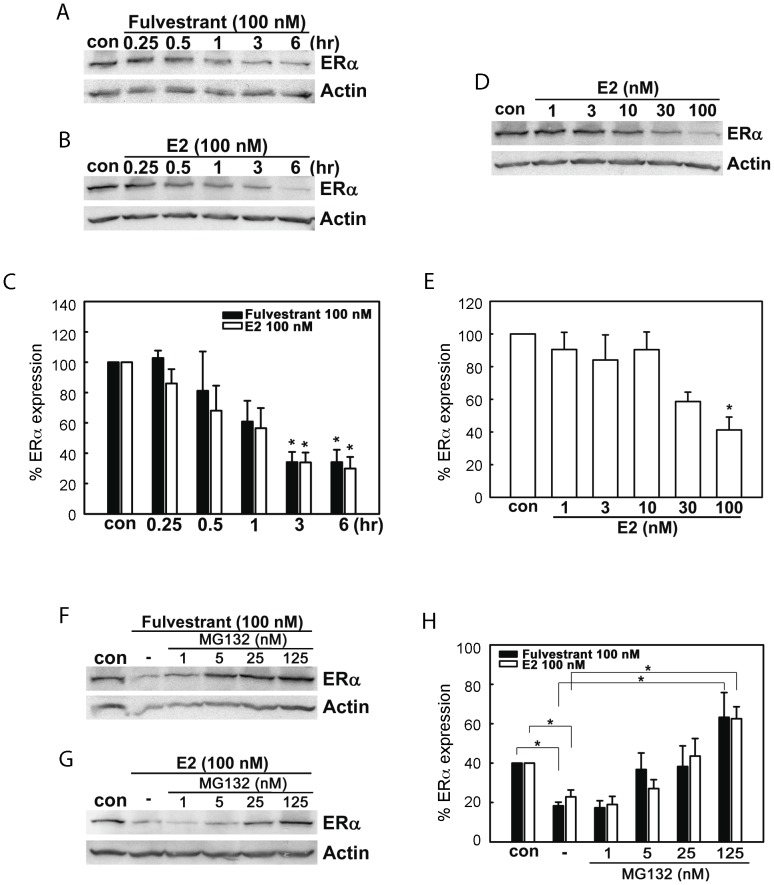
Both fulvestrant and 17β-estradiol (E2) enhance proteasomal degradation of ERα protein in MCF-7 cells.(A–C) Fulvestrant (A) and E2 (B) caused time-dependent reduction in ERα protein expression: Western blotting. Intensities of ERα protein bands were determined by densitometry (C, mean±SEM of three independent experiments. Asterisks indicate statistical significance, p<0.05 to vehicle control). (D, E) E2 dose-dependent reduction in ERα protein expression. Cells were exposed to varying concentrations of E2 for 6 hours and subjected to Western blotting analysis of ERα protein (D). Intensities of ERα protein bands were determined by densitometry (E, mean±SEM of three independent experiments. Asterisk indicates t-test significance p<0.05 to vehicle control). (F–H), Pre-exposure to MG132 dose-dependently prevented reduction in ERα protein expression caused by fulvestrant (F) and E2 (G). Con, vehicle control (0.1% ethanol). Cells were exposed to varying concentrations of MG132 for 30 minutes and then exposed additionally to fulvestrant or E2 for 6 hours. Intensities of ERα protein bands were determined by densitometry (H, mean±SEM of three independent experiments. Asterisks indicate statistical significance, p<0.05).